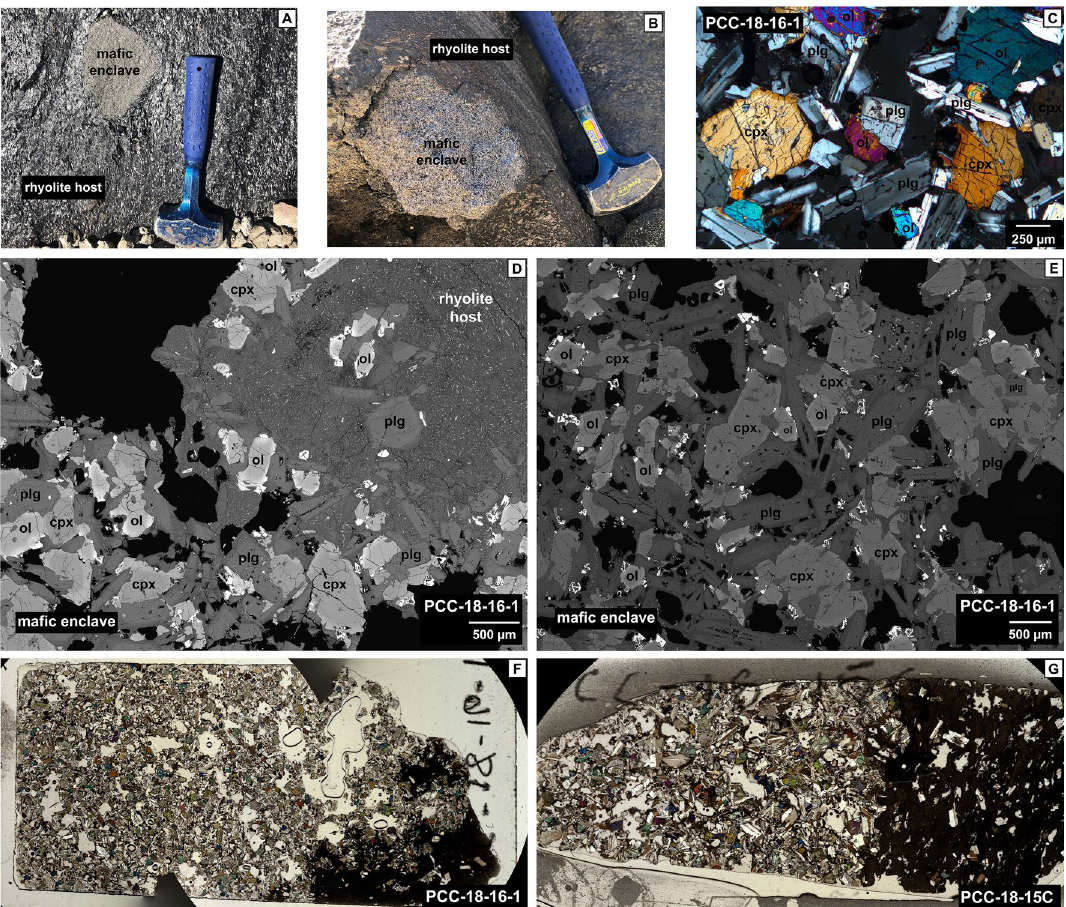
Figure 2. Textural images of the coarsely-crystalline enclave population. ( a , b ) Field photos of mafic enclaves in rhyolite host with hammer for scale. ( c ) Micrograph highlighting enclave mineralogy, crystallinity, and interlocking grain texture. ( d ) Backscattered electron (BSE) map of mafic enclave-rhyolite host boundary. ( e ) BSE map of enclave core. ( f , g ) Thin section scans of coarsely-crystalline enclaves highlighting crystallinity, mineralogy, and enclave-host